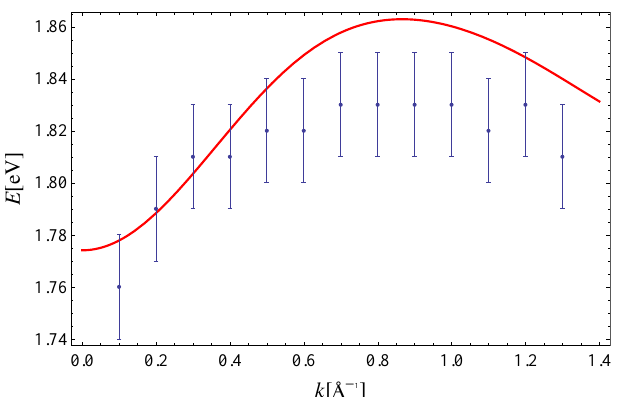
Figure 4. Exciton dispersion along the ( 120 ) direction. Experimental data are taken from Reference [3]. The parameters used for the theoretical fit are as in Figures 2 and 3.